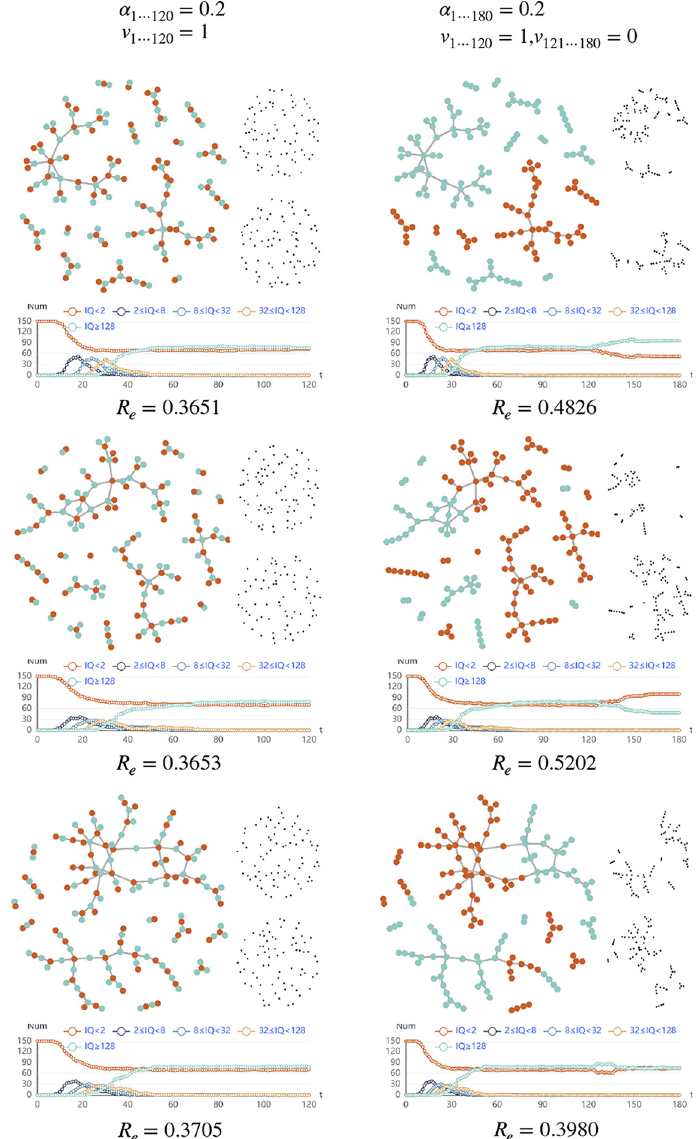
Figure 5. Evolutionary distribution of wisdom under extreme volatility rate. The distribution on the left is the result of 120 evolutions with v = 1. Keeping the same distribution, we suddenly get volatility rate down to 0 and evolve it 60 times to get the distribution on the right. For different intelligence, we extract their distributions and measure the Kullback – Leibler divergence of